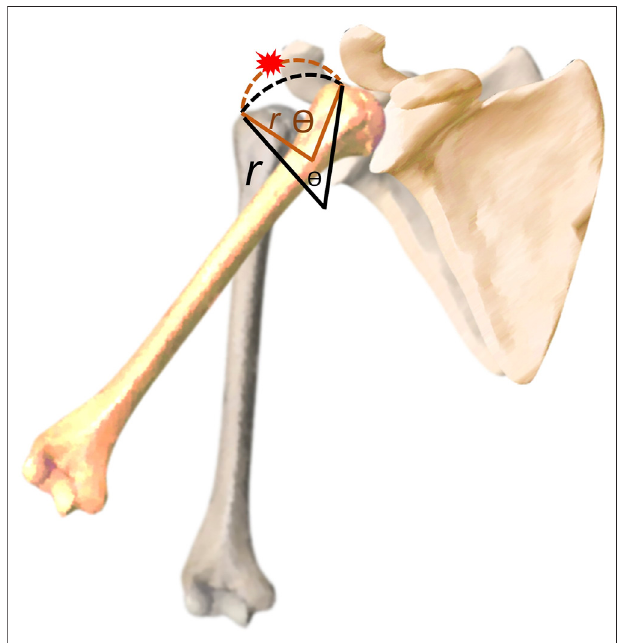
FIGURE 4 | Illustration of the association between the rotation angle ( Ѳ ) and radius ( r ) and why a bigger angle is associated with an increased risk of subacromial